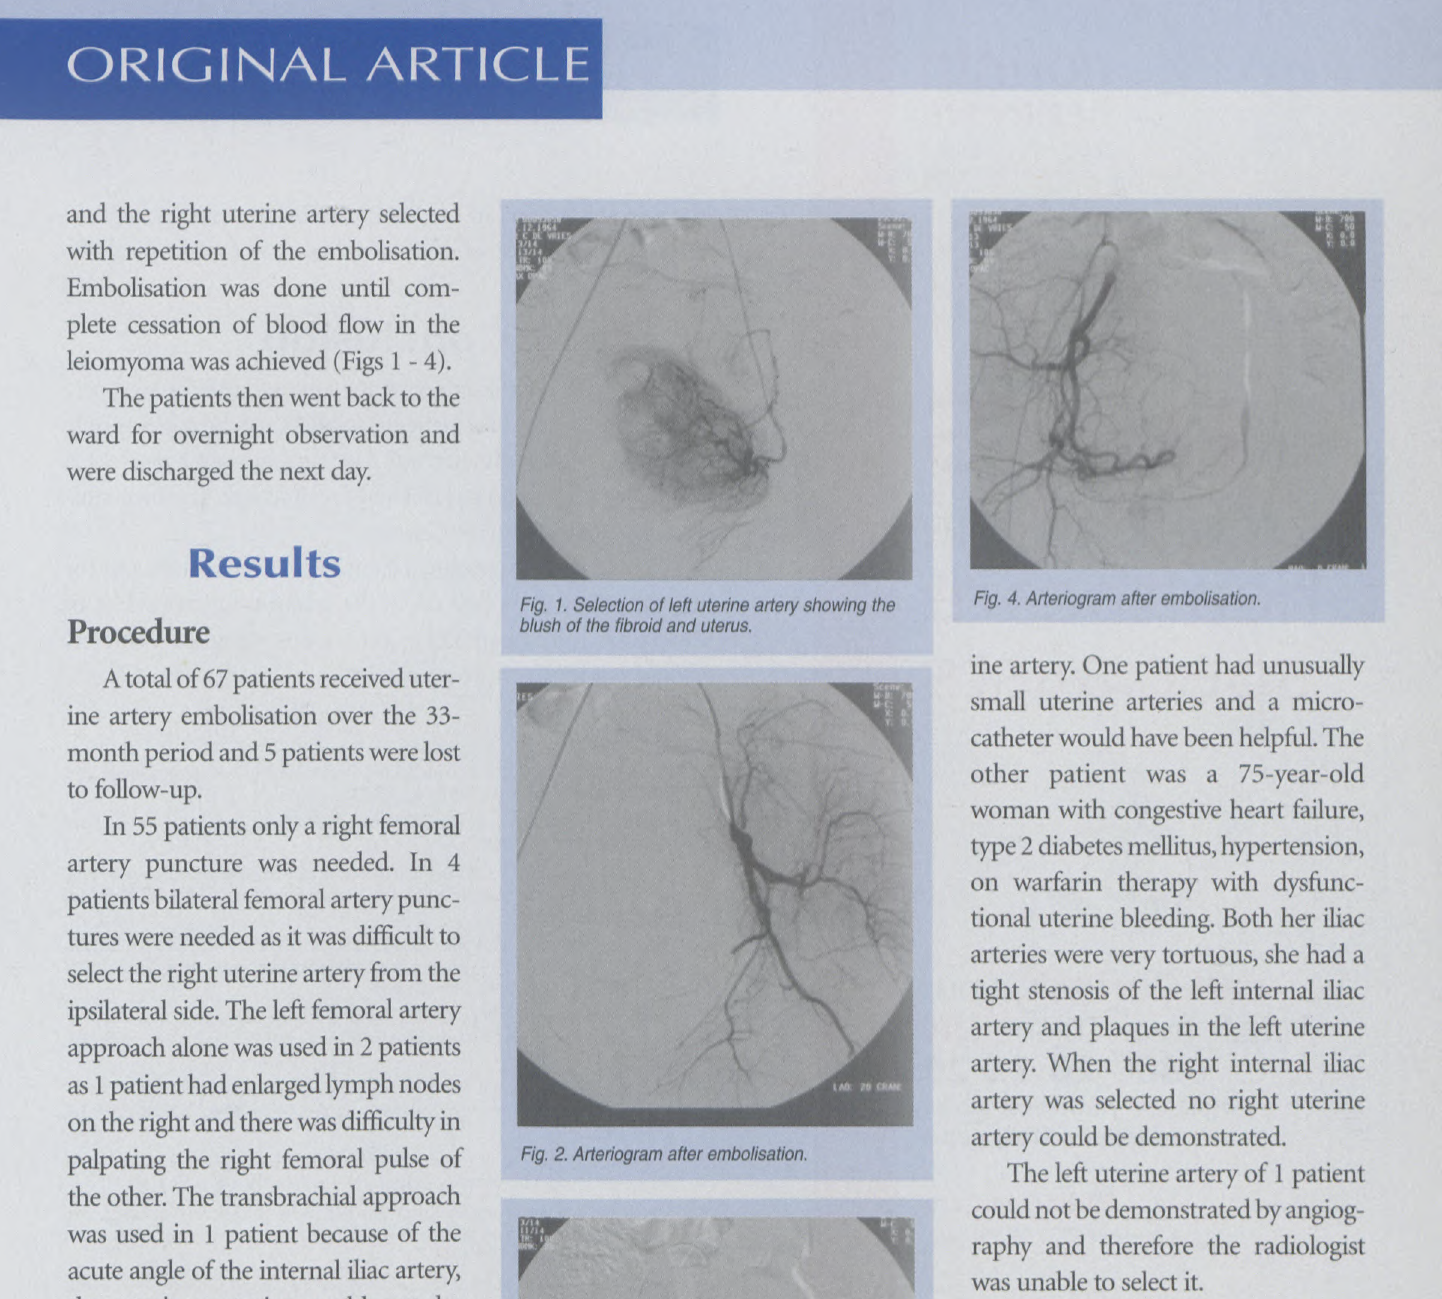
Fig. 2. Arteriogram after embolisatlon.